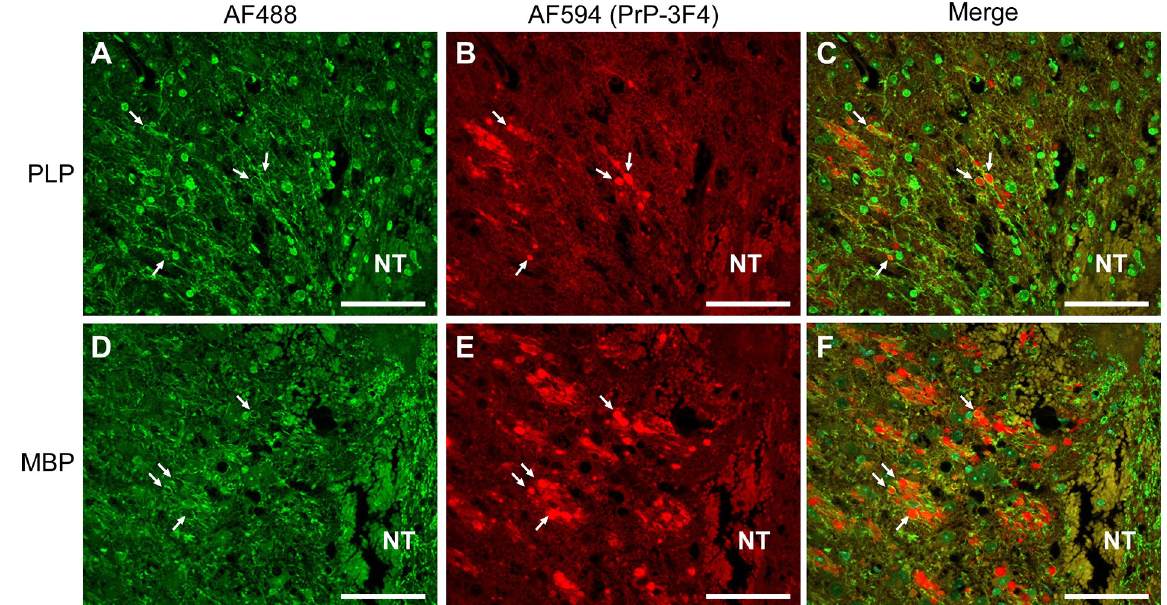
Fig 9. Intra-axonal localization of PrP-3F4 in the brain of Tg3F4 mice inoculated with ME7 prions. Damaged brain tissue surrounding the needle track in the thalamus of Tg3F4 mice 48 hrs post-inoculation with ME7. Sections were co-stained with antibodies to either (A) PLP and (B) PrP-3F4 or (D) MBP and (E) PrP-3F4. Panels C and F show the merged images of the preceding panels. Arrows show where PrP-3F4 staining is surrounded by either PLP or MBP staining, indicating intra-axonal localization of PrP-3F4. PrP-3F4 was detected using